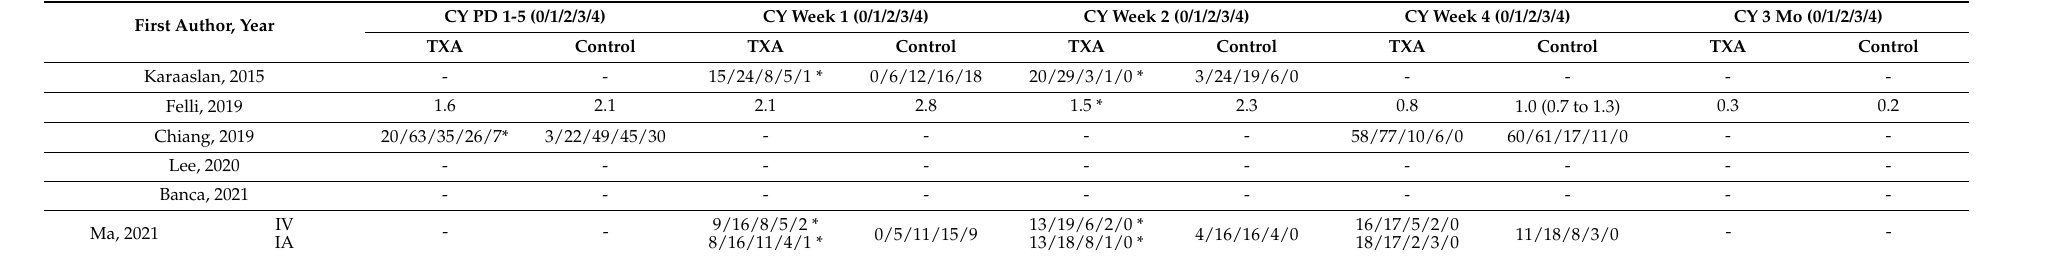
Table 3. Hemarthrosis grade with the aid of the Coupens and Yates grading system for all included